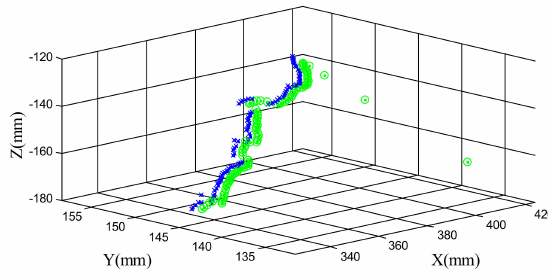
Figure 9. Measuring position and filtered position of marker.